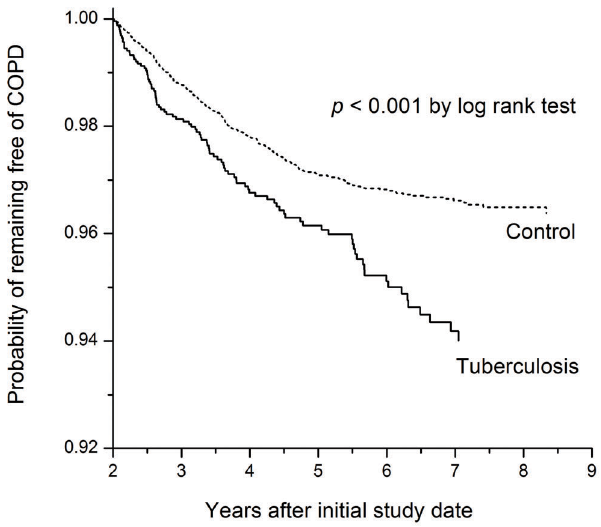
Figure 3. Curves of time to onset of chronic obstructive pulmonary disease (COPD) among tuberculosis and control